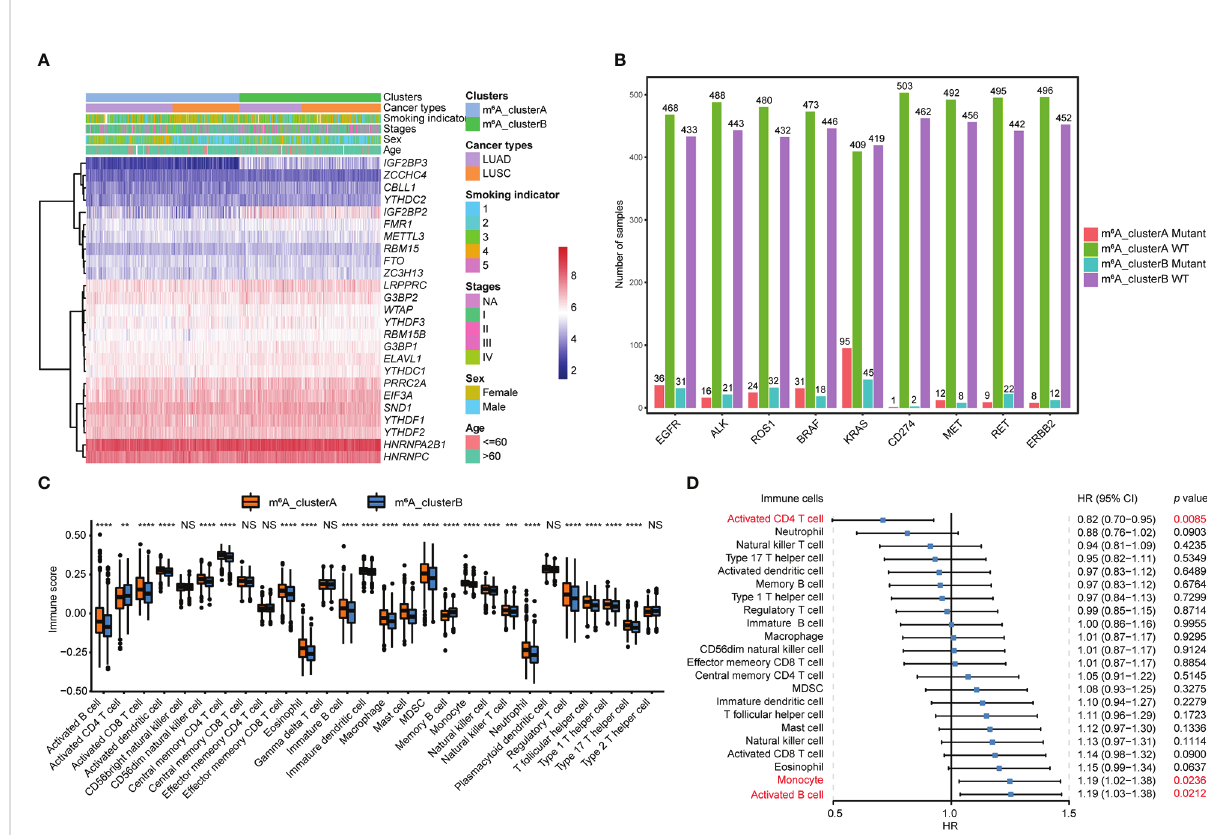
FIGURE 3 Transcriptome characteristics and immune cell in fi ltration features in two m 6 A regulator gene clusters. (A) The expression pattern of the m 6 A regulator genes between the two m 6 A clusters that matched the clinical information, including cancer type, smoking indicator, stage, sex, and age. (B) The nine most common gene mutation statuses in NSCLC. (C) The boxplot shows the abundance of 28 in fi ltrating immune cells among the two m 6 A clusters. NS p > 0.05; ** p < 0.01; *** p < 0.001; **** p < 0.0001. (D) Forest plots of hazard ratios (HRs) for 22 immune in fi ltration cells associated with OS and meaningful immune cells were marked in red ( p <